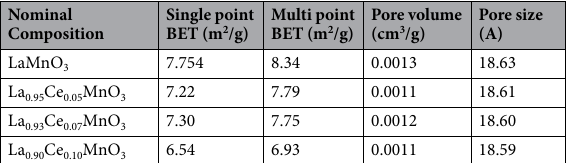
Nominal Composition